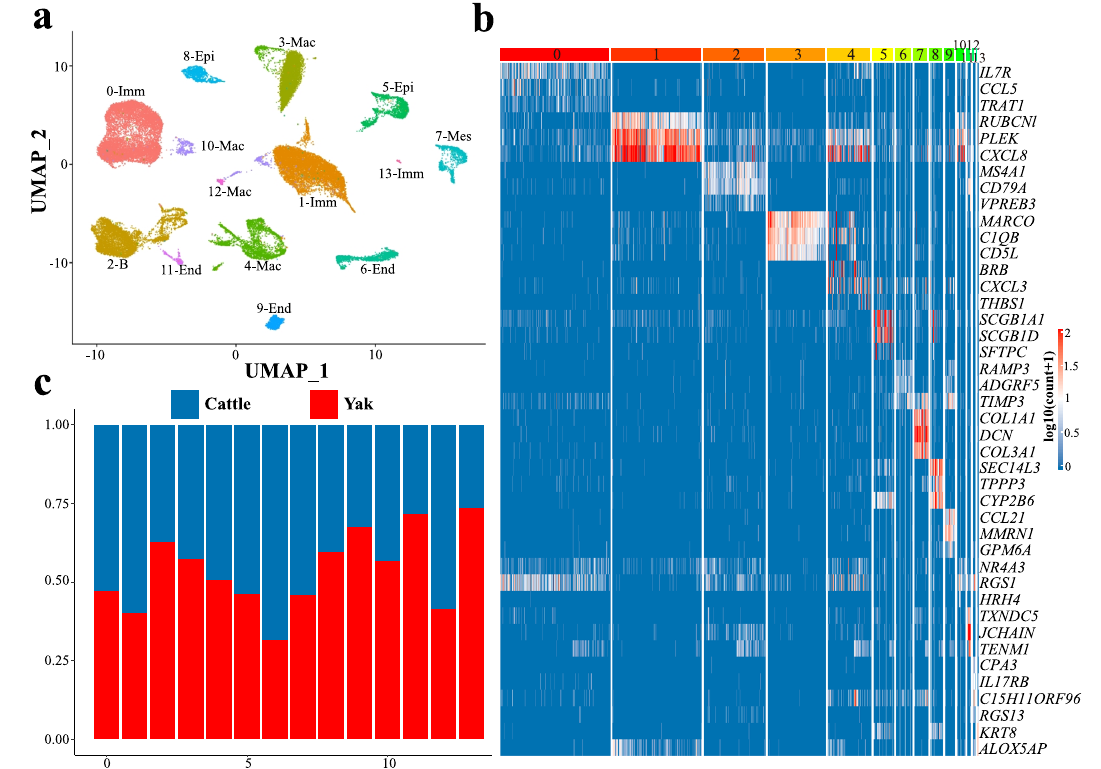
Fig. 5 | Integrative analysisofsingle-cell RNA-seqdata inthe domestic yakand taurinecattlelungs.a UMAPclusteringofdifferentcellclusters. b Heatmapofthe expressions of speci fi c marker genes in each cluster. c Histogram of the ratios of